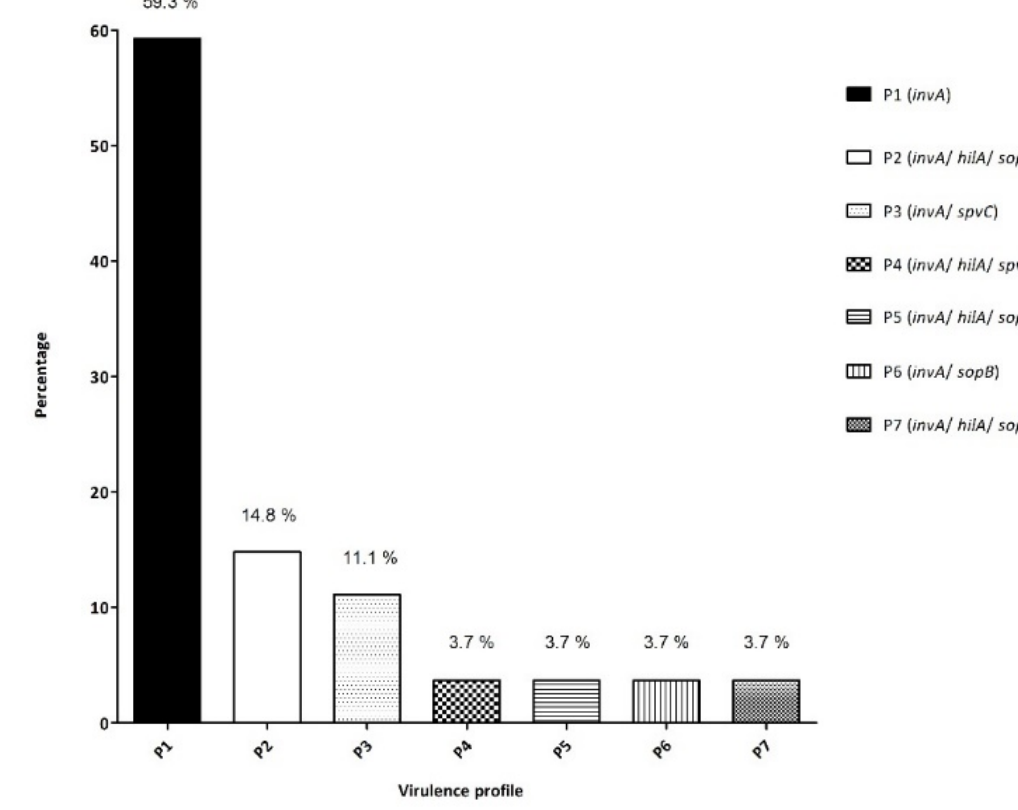
Figure 2. Virulence profiles obtained for the 27 isolates analyzed, based on the presence of the genes invA , hilA sopB , pefA and spvC .